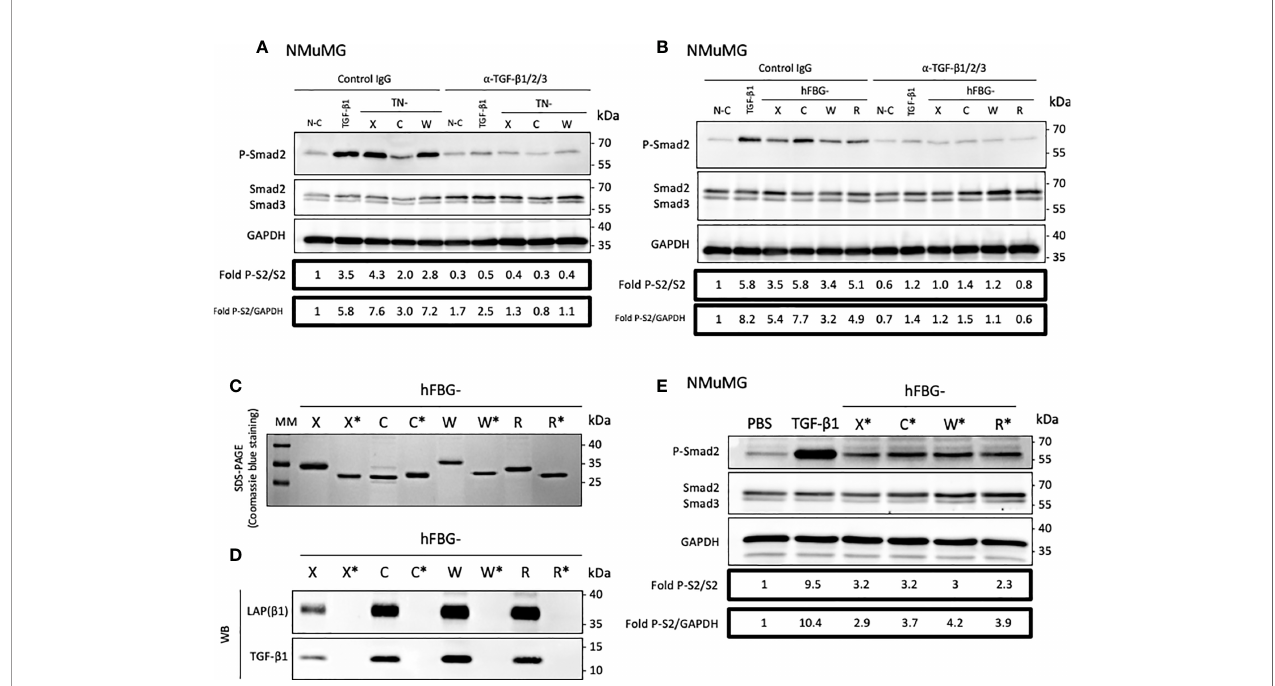
FIGURE 5 | The FBG-like domain of the Tenascin family members activates the latent TGF- b in epithelial cells. (A) Western-blot analysis showing P-Smad2, total Smad2/3 and GAPDH levels in NMuMG cultured for 3h onto Non-Coated (N-C) dishes, dishes coated with 22,2 pmol/cm 2 full-length Tenascins (TN) or stimulated with 2 ng/mL TGF- b 1, in presence of anti-pan-TGF- b antibody or isotype-matched control IgG (10 m g/mL). (B) Western Blot analysis showing P-Smad2, total Smad2/3 and GAPDH levels in NMuMG cells cultured for 3h in presence of 333 pmol/cm 2 of FBG-like domains as described in (A) . (C) SDS-PAGE analysis of puri fi ed recombinant FBG-like domains produced in mammalian cells (FBG) and E. coli (FBG*) resolved on 15% acrylamide gels under reducing conditions (2 µg each). MM, molecular mass markers. (D) Western-Blot analysis of the levels of mature TGF- b 1 and LAP( b 1) pro-domain associated with 20 pmol of FBG-like domains produced in mammalian cells (FBG) and E coli (FBG*). (E) Western-blot analysis showing P-Smad2, Smad2/3 and GAPDH levels in NMuMG cells stimulated for 1h with active TGF- b 1 (2 ng/mL), soluble puri fi ed FBG-like domains produced in E Coli (720 nM) or vehicle